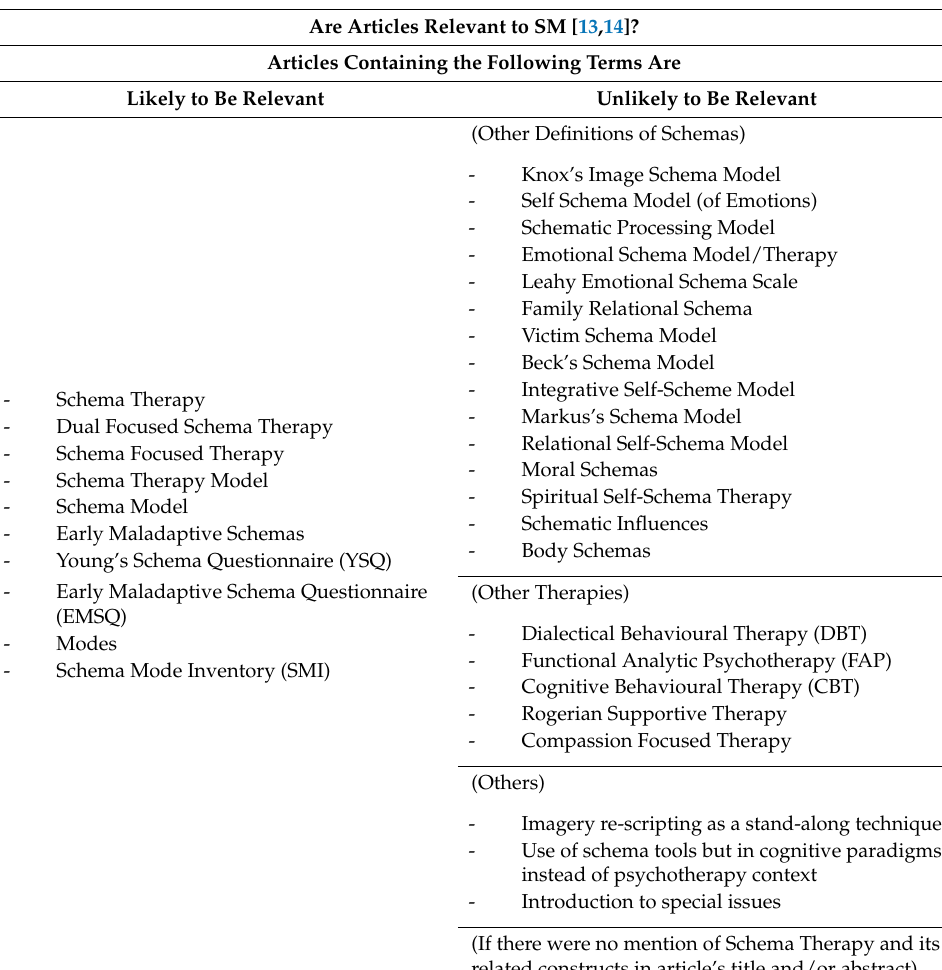
Table 1. Checklist to guide first stage screening for scoping